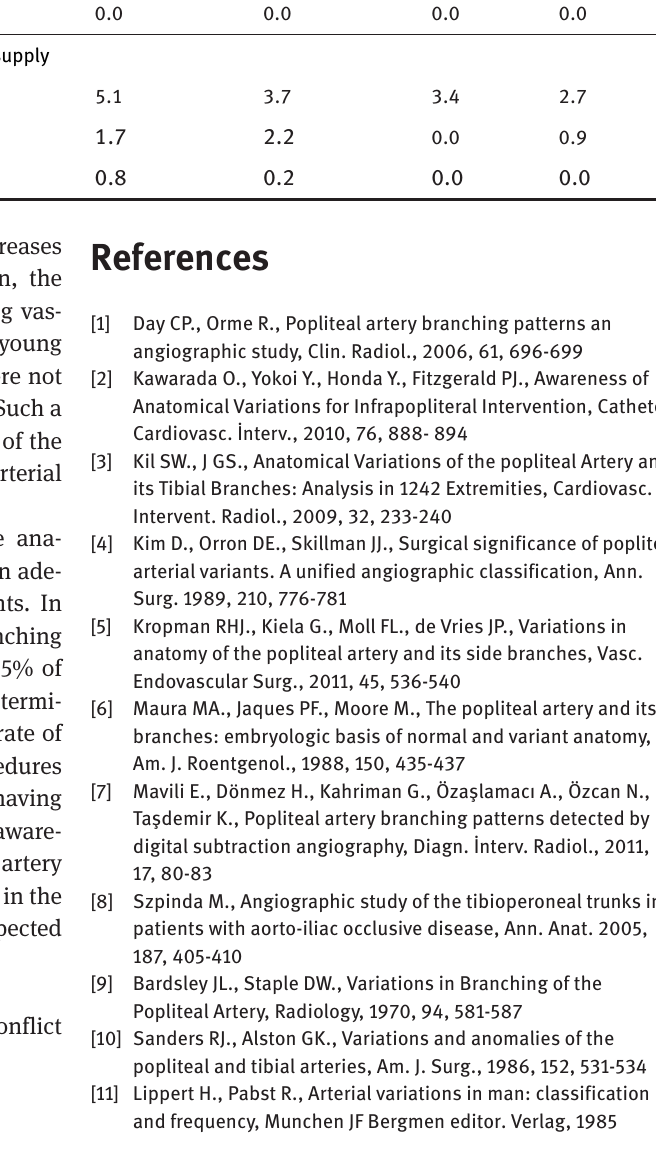
Dissection Digital subtraction Branching patter n